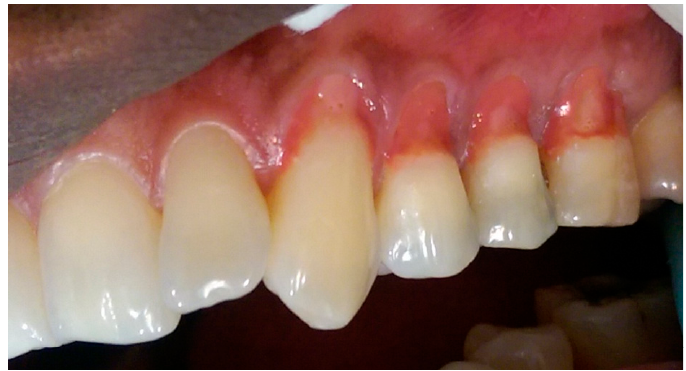
Figure 3. Light and white opaque placement.